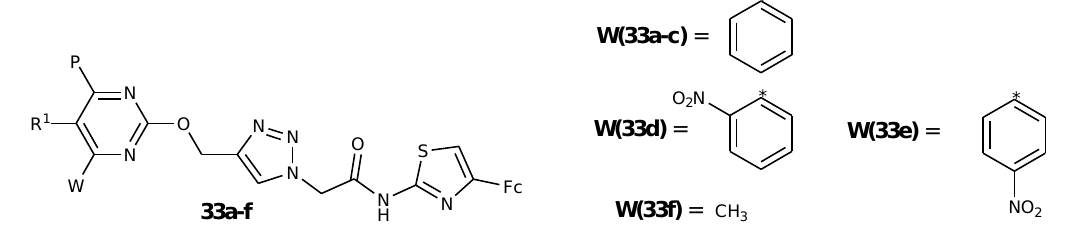
Figure 14. Schematic route showing the synthesis of ferrocene-pyrimidine conjugates ( 33a – f ).